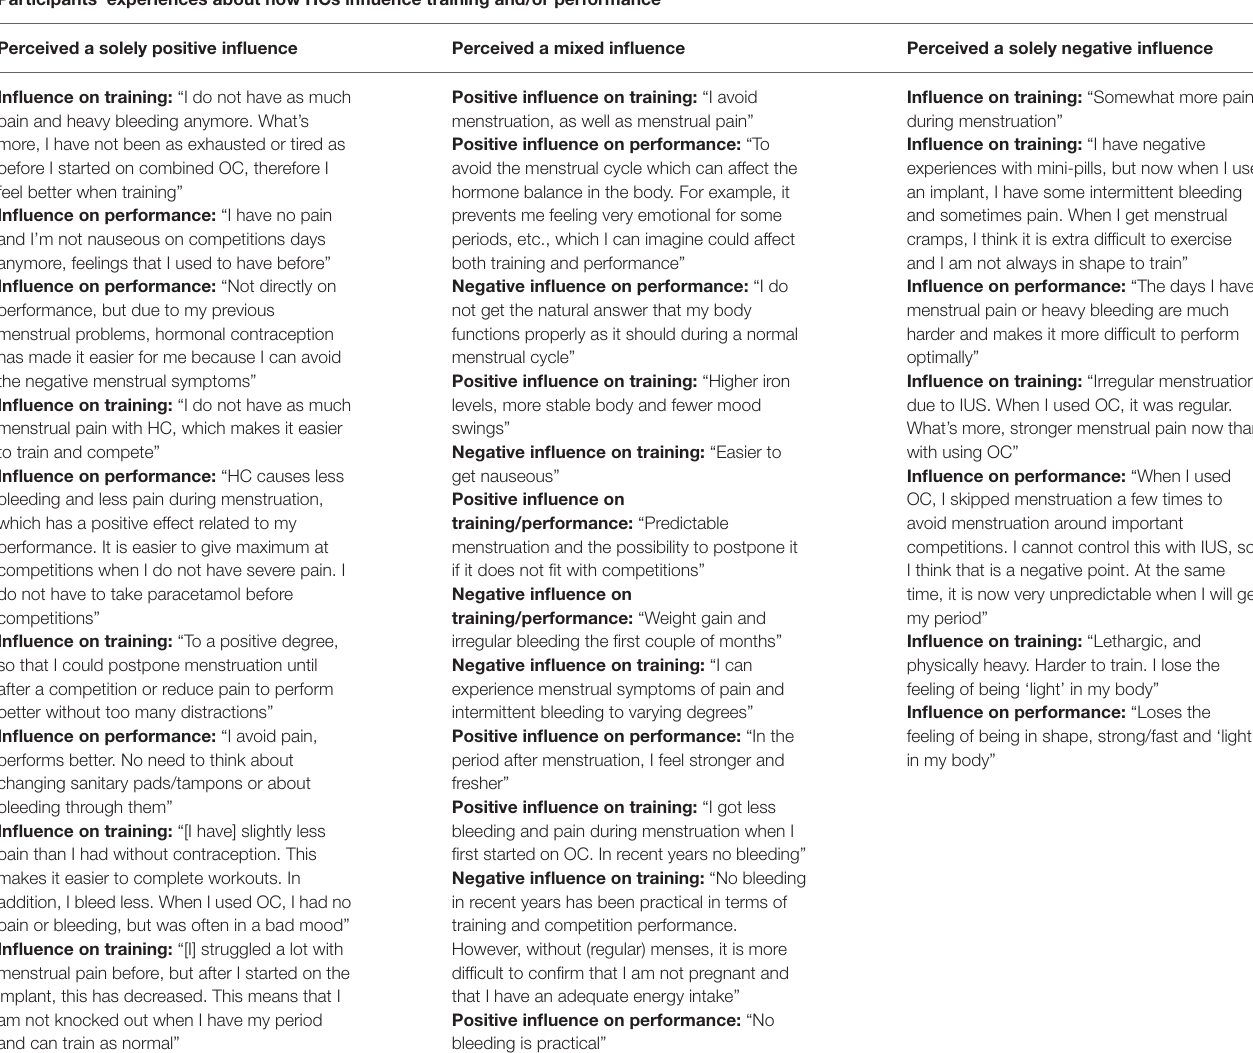
TABLE 5 | Selection of responses: how hormonal contraceptives (HCs) influence training and/or performance. Participants’ experiences about how HCs influence training and/or performance Perceived a solely positive influence Perceived a mixed influence Perceived a solely negative